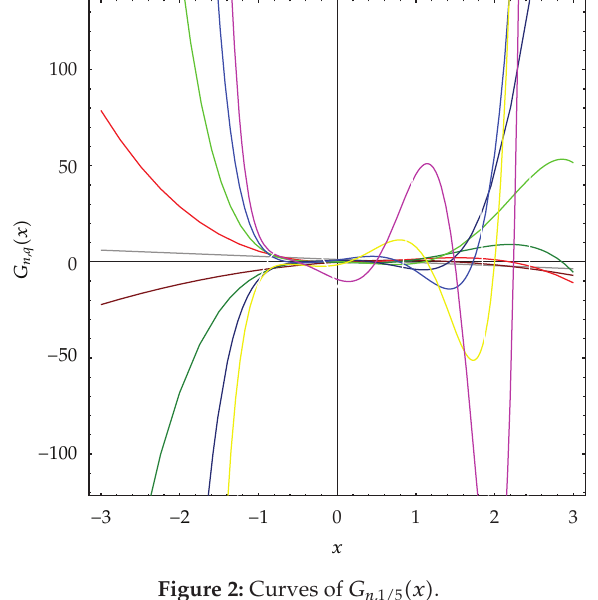
Figure 2: Curves of G n, 1 / 5 (cid:2) x (cid:3) .